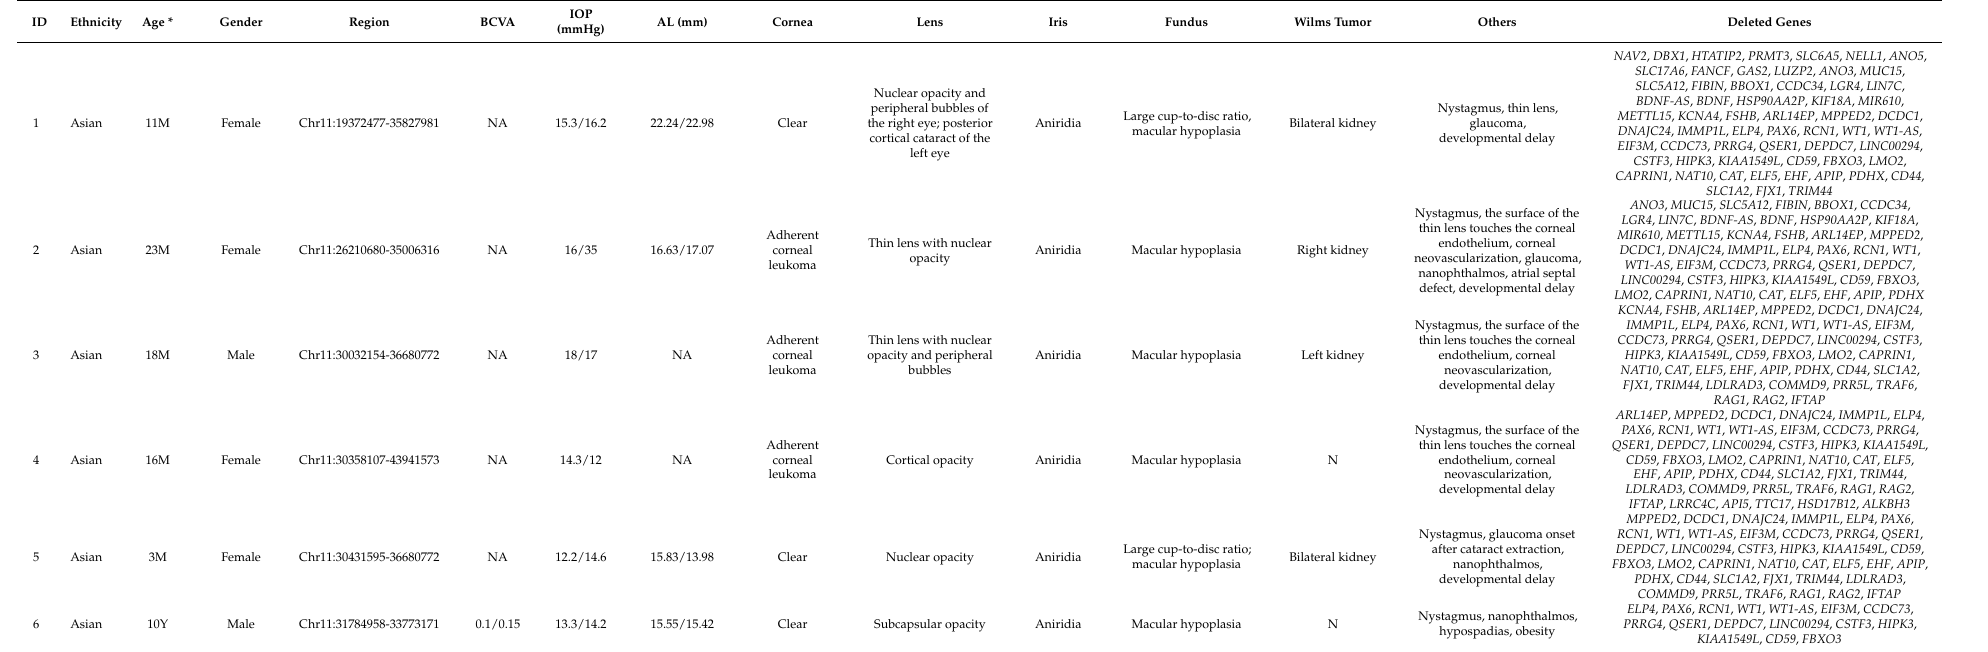
Table 1. Patient Profiles: Clinical and genetic information of the patients with WAGR